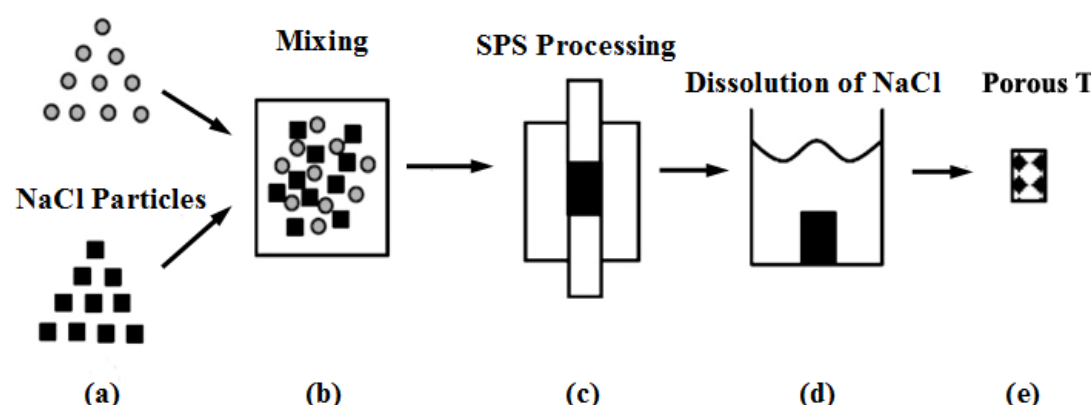
Figure 20. Schematic illustration of the fabrication process by using SPS and sodium chloride dissolution: ( a ) sieving of the titanium and sodium chloride powders; ( b ) mixing of the titanium and sodium chloride powders; ( c ) processing by the SPS; ( d ) dissolution of the sodium chloride in water; ( e ) obtaining of the porous titanium.